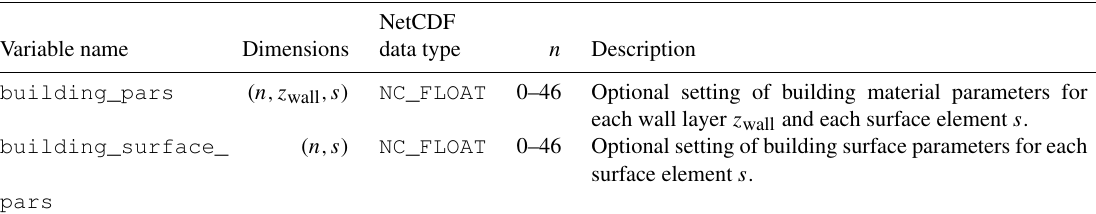
Table 4. List of LOD4 variables that can be specified in the static driver